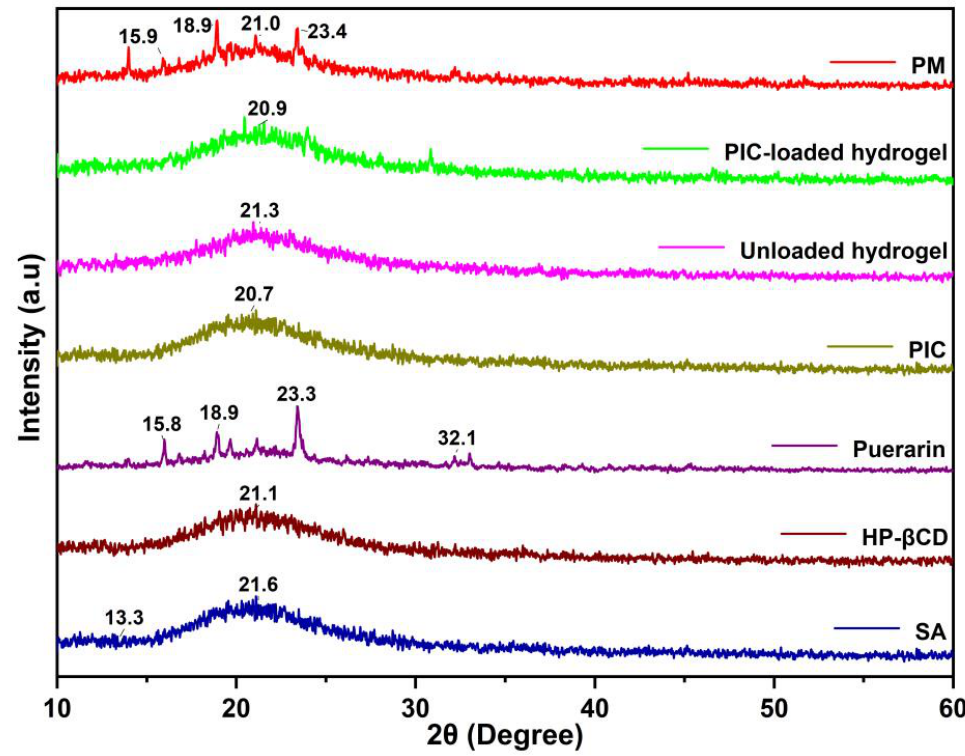
Figure 4. TheXRDpatternoftheformulationingredients, inclusioncomplexes, Figure 4. The XRD pattern of the formulation ingredients, inclusion complexes, and hydrogels syn- thesized.